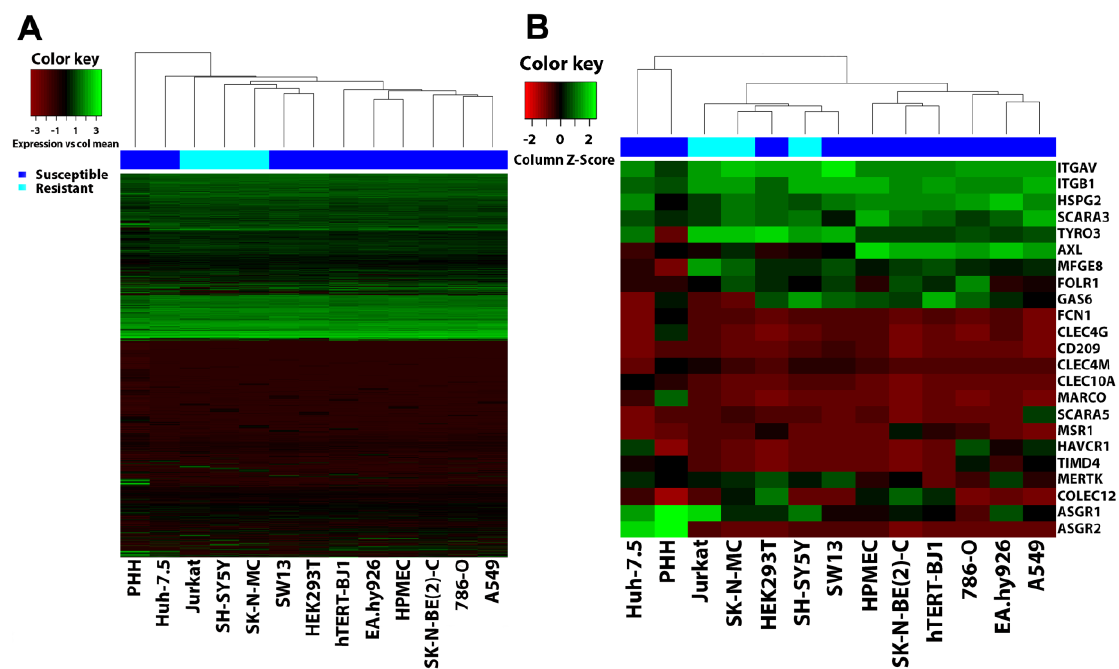
Figure 6. Hierarchical clustering analysis (HCA) does not correlate gene expression to susceptibility to filovirus infection. Microarray data of cell lines tested for susceptibility to filovirus infection as well as primary human hepatocytes (PHH) were clustered based on ( A ) their global gene expression or ( B ) gene expression of attachment factors implicated in filovirus entry using the heatmaps.2 of the R library “glplots” package. Transcript probes that yielded no detectable signal were removed prior to analysis. Heatmaps were generated by plotting cell lines as columns and genes as rows using the “complete” method for clustering and “Euclidean” method for distance calculation. In the bar above the heatmaps dark blue represents susceptible cell lines and light blue resistant cell lines.